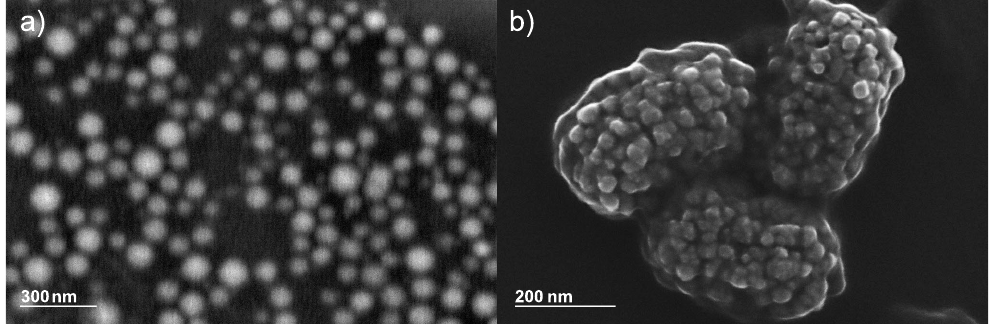
Figure 3. ( a ) Scanning electron microscopy image (4keV) of dispersed nanoclusters after 250kGy electron beam irradiation ( b ) Scanning electron microscopy image (15keV) of agglomeration of nanoclusters after 150kGy electron beam irradiation.